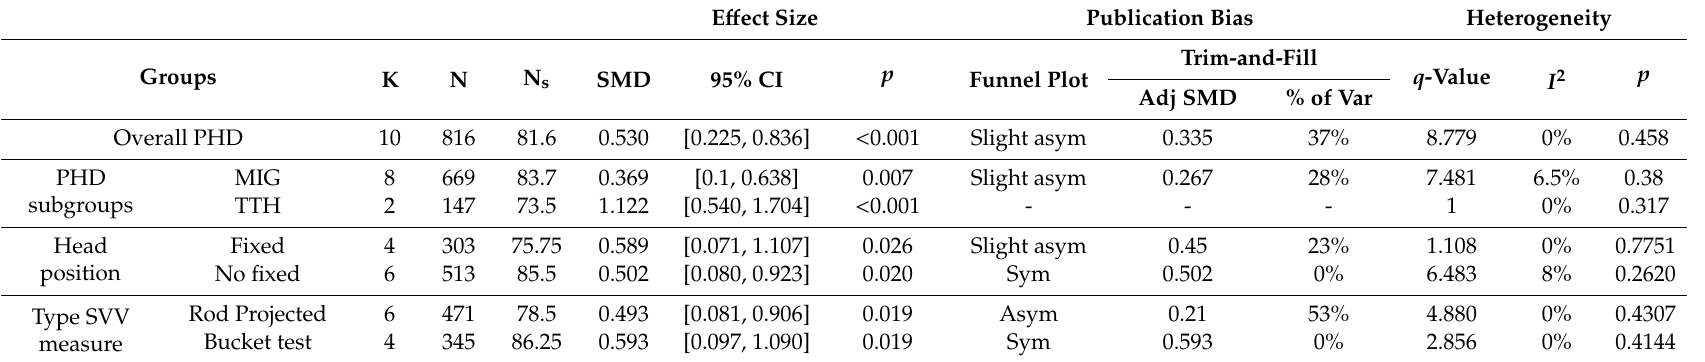
Table 5. Summary of findings in the